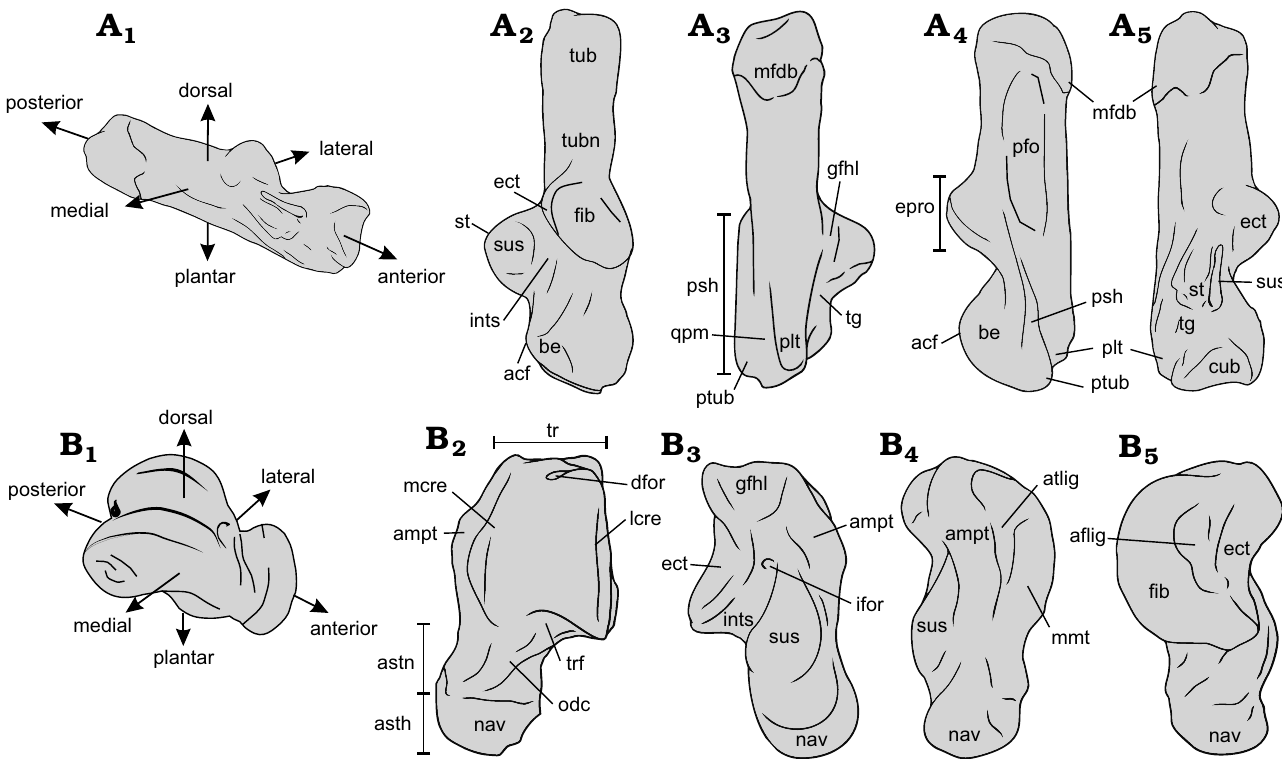
Fig. 2. Ungulate left proximal tarsal terminology. A . Calcaneum; orientation used for description (A 1 ), dorsal (A 2 ), plantar (A 3 ), lateral (A 4 ), and medial (A 5 ) views. B . Astragalus; orientation used for description (B 1 ), dorsal (B 2 ), plantar (B 3 ), medial (B 4 ), and lateral (B 5 ) views. Abbreviations: acf, astraga- localcaneal facet; aflig, attachment for the fibuloastragalar ligament; ampt; astragalar medial plantar tuberosity; asth, astragalar head; astn, astragalar neck; atlig, attachment for the tibioastragalar ligament; be, “beak” (Cifelli 1983, 1993); cub, cuboidal facet; dfor, dorsal astragalar foramen; ect, ectal facet; epro, ectal protuberance; fib, fibular facet; gfhl, groove for the tendon of the flexor hallucis longus muscle (groove for deep digital flexor tendon in Cifelli 1983; groove for the tendon of muscle flexor fibularis in Szalay 1985); ifor, inferior astragalar foramen; ints, interarticular sulcus; lcre, lateral crest; mcre, medial crest; mfdb; muscle flexor digitorum brevis (attachment of flexor digitorum superficialis muscle in Cifelli 1983); mmt, facet for the medial malleolus of the tibia; nav, navicular facet; odc, oblique dorsal crest (nuchal crest or tibial stop); pfo, peroneal fossa; plt, plantar tubercle; psh, peroneal shelf; ptub, peroneal tubercle; qpm, attachment of the quadratus plantae muscle (Cifelli 1983); st, sustentaculum; sus, sustentacular facet; tg, tendinous groove (for the attachment of calcaneocuboid ligaments; Muizon et al. 1998); tr, tibial trochlea; trf, fossa trochlear; tub, tuber calcis; tubn, tuber